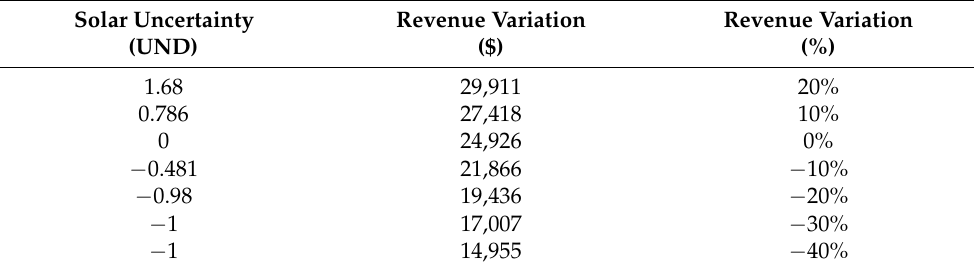
Table 4. Optimal sizing of the batteries when the solar generation forecast